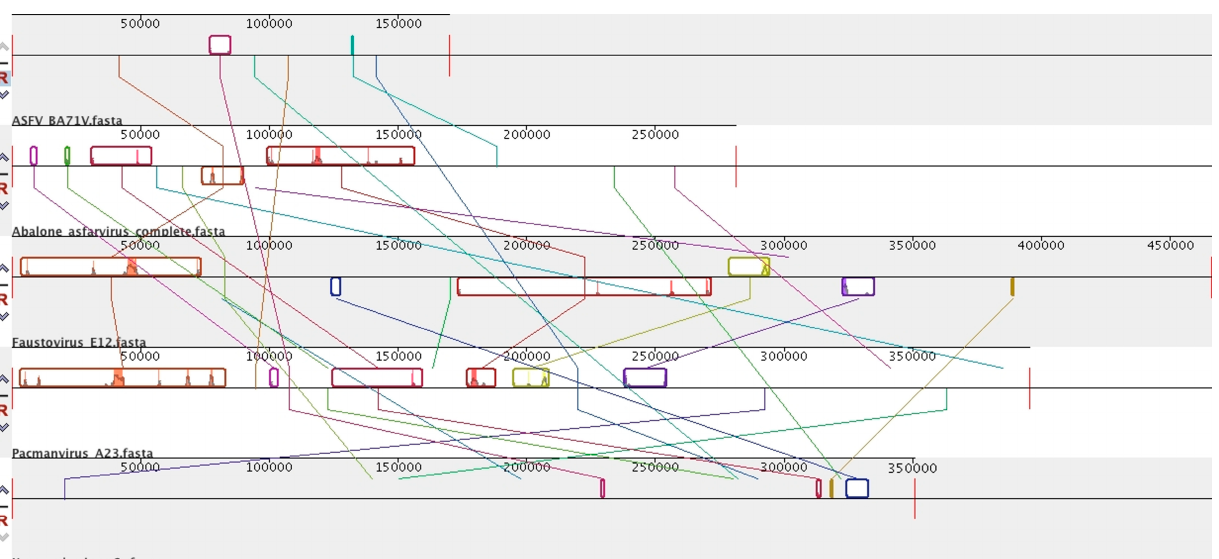
Figure 3. Mauve alignment genome of some Asfarviridae and other related viruses. Schematic genome alignment obtained using the Mauve software [102]. The analysis was performed using the genome of ASFV strain BA71V (NC_001659.2), Abalone Asfarvirus (LC637659.1), Faustovirus E12 (KJ614390.1), Pacmanvirus (LT706986.1) and Kaumoebavirus (KX552040.1). The blocks illustrated above the x axis are in the positive strand (forward sense), while blocks below the x axis are in the negative strand (reverse sense). Names of each virus are indicated below the sequence. The connected lines represent the relatively similar blocks between the